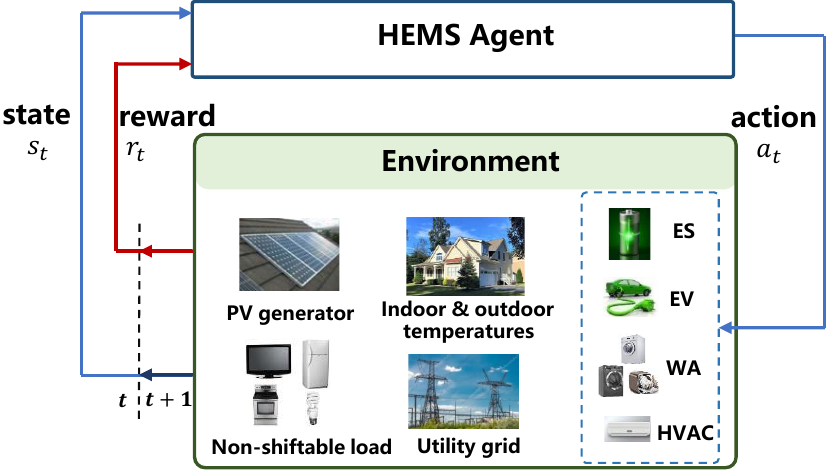
Figure 2. Interactions between agent and environment in the Markov decision process